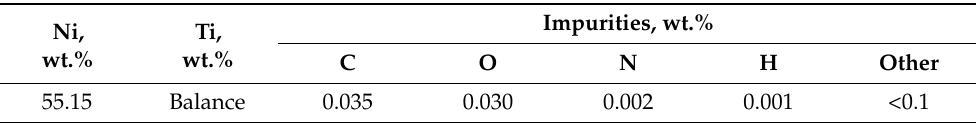
Table 1. Chemical composition of the TiNi SMA rod with a diameter of 12 mm, used as a charge material for melting of TiNiHf initial